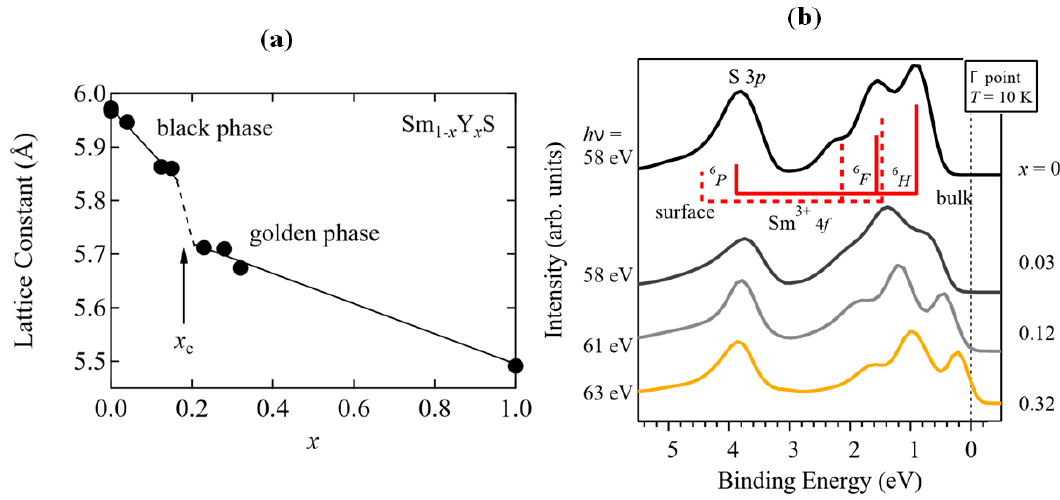
Figure 4. ( a ) Yttrium concentration dependence of the lattice constant of the SmS-based single crystal; ( b ) The density of states at the Γ point of the Brillouin zone of the SmS-based material. The photon energies and concentrations of Y are placed on the left and the right side of the graph, respectively. (Reprinted with permission from [42].)